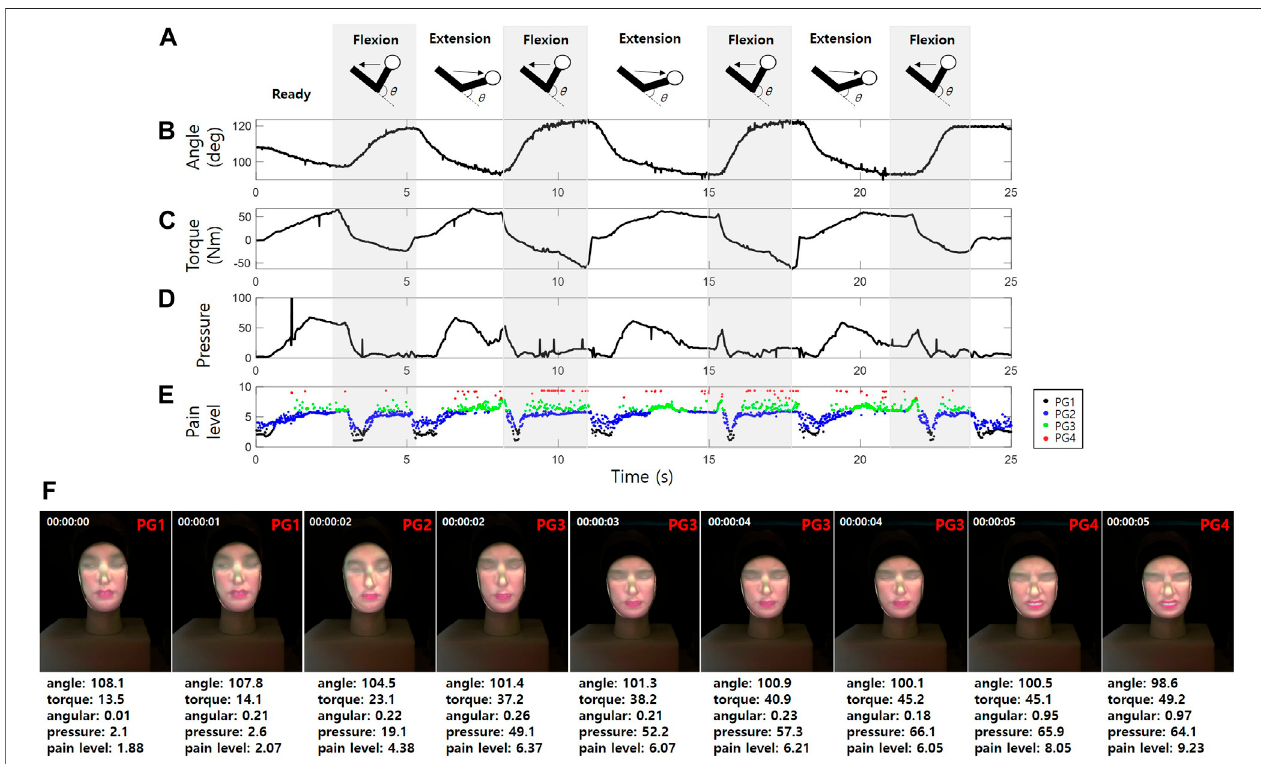
FIGURE8| ExampleofquantitativedataoutputfromtheelbowjointofCaTARo: (A) elbowkinematics, (B) elbowjointangle, (C) torque, (D) pressuredata, (E) pain level extracted by fuzzy logic, and (F) testing of 3D facial pain expression with CaTARo.